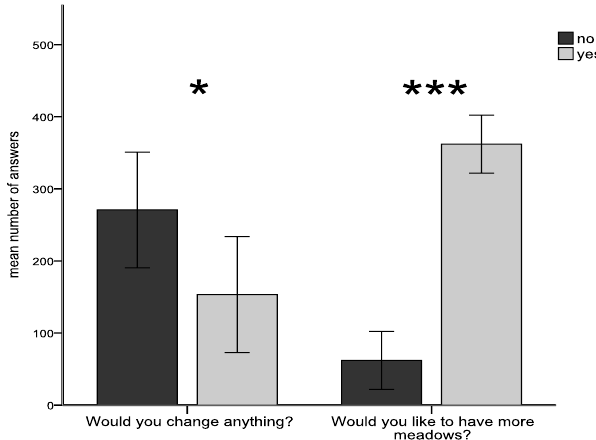
Figure 3. The graphic display of the questions: “Would you change anything?” ( t -test, n = 6, 424 participants), p = 0.021 ( * ) and “Would you like to have more meadows?” ( t -test, n = 6, 424 participants) p = 0.000 ( *** ). Values are arithmetic means ± standard